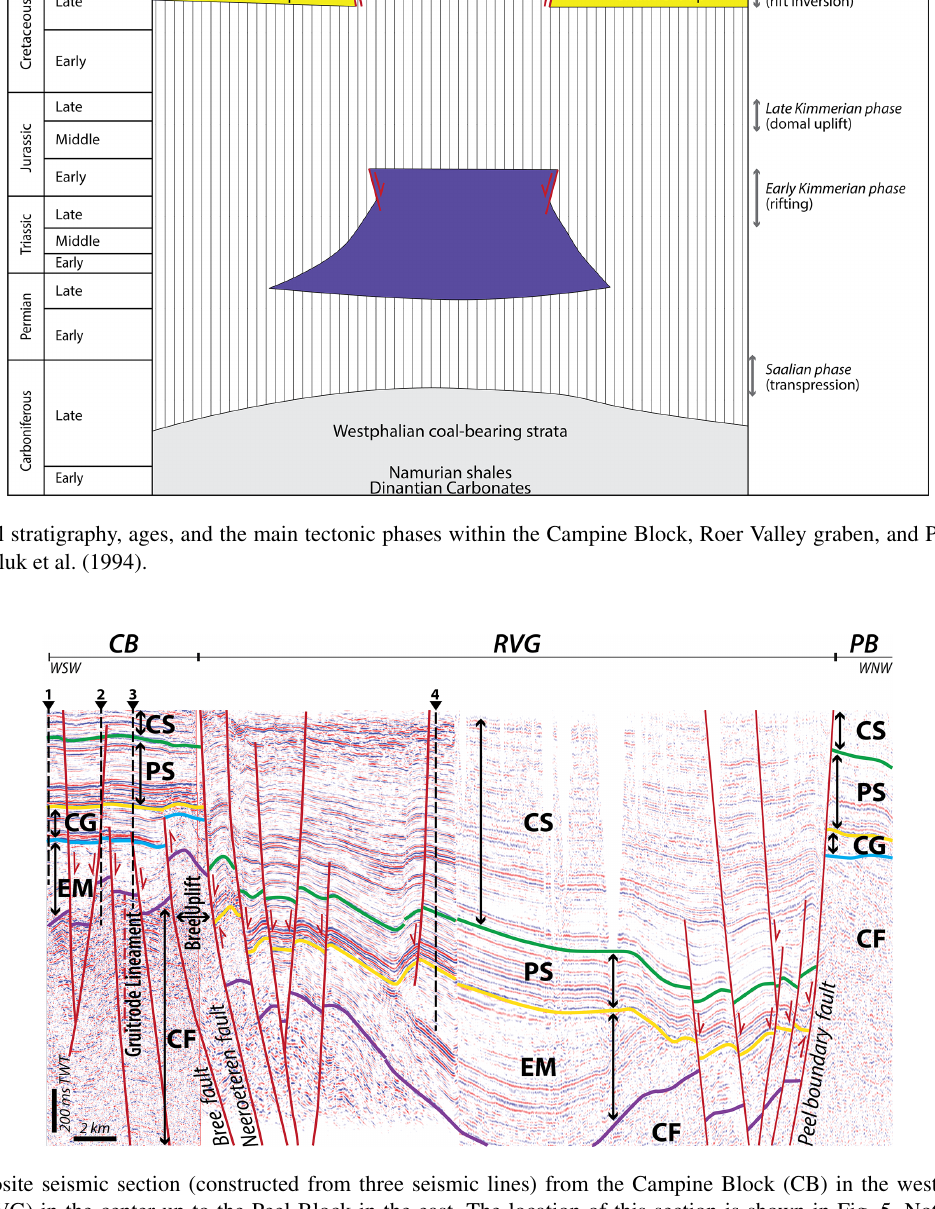
Solid Earth, 12, 345–361,